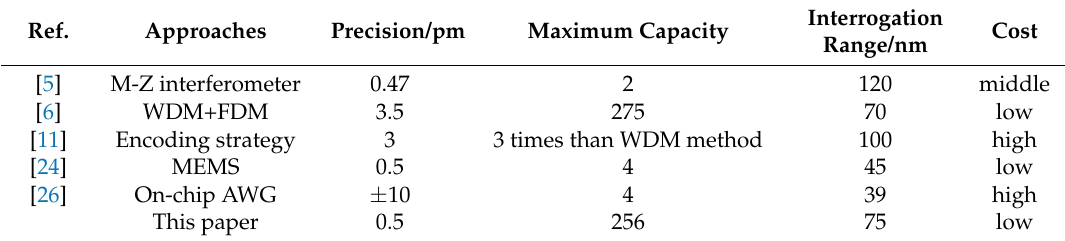
Table 3. The contrasts of different interrogation